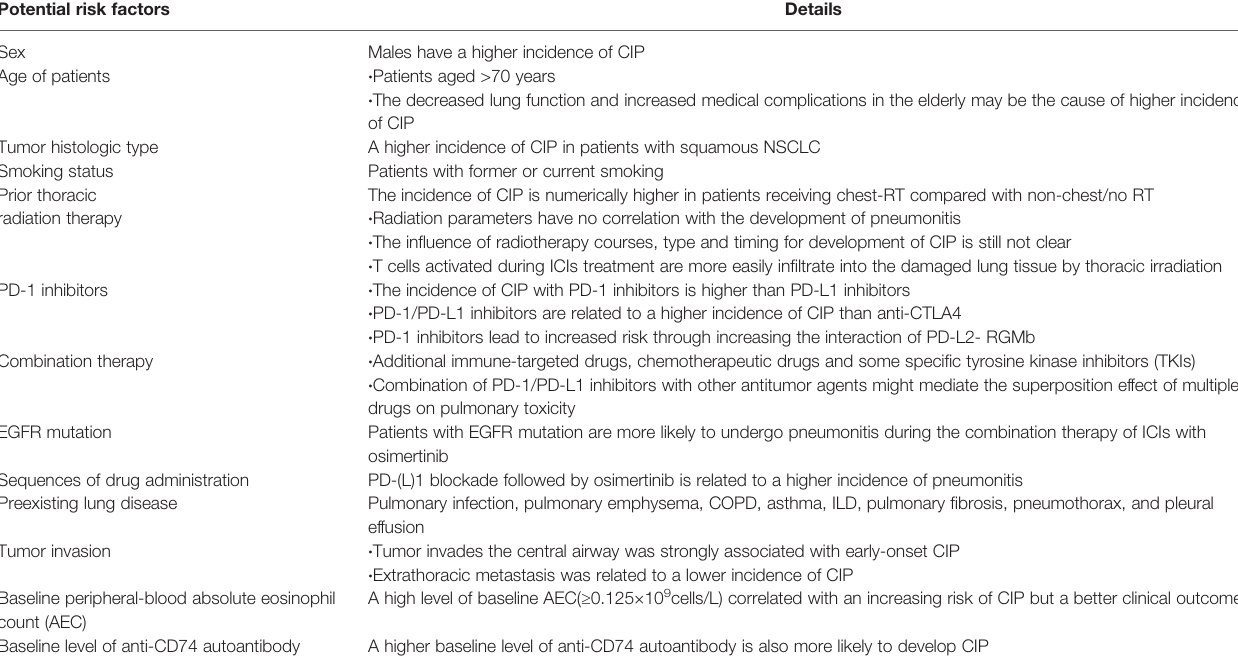
TABLE 3 | Potential risk factors for checkpoint inhibitor pneumonitis (CIP) in